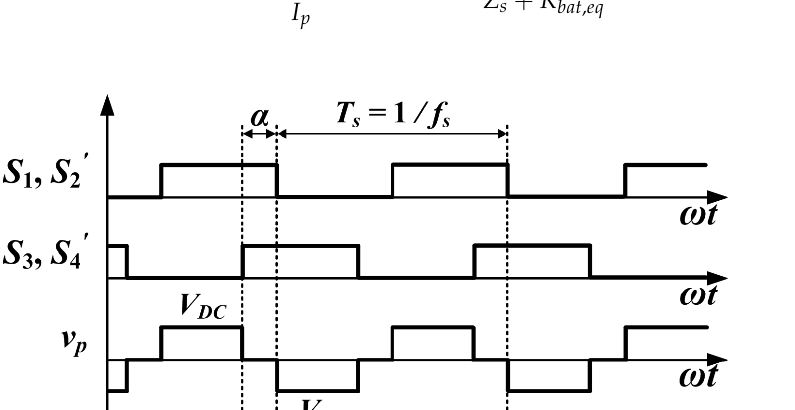
Figure 3. ( a ) Schematic diagram of the proposed single-stage wireless battery charging circuit; ( b ) Equivalent of the pro- posed